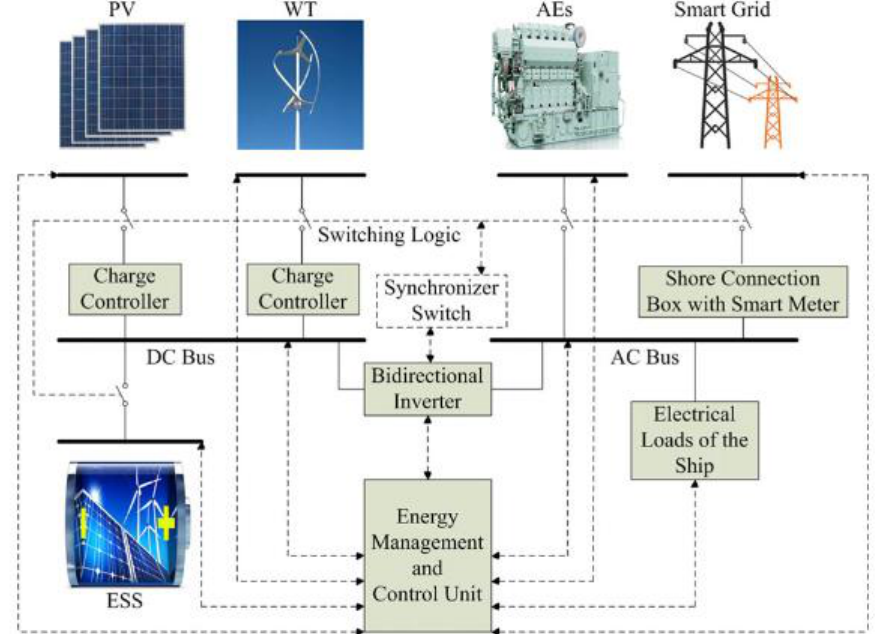
Figure 23. Control and power switching topology for the ship and smart grid system. Reprinted with permission from ref. [103]. Copyright © 2018 John Wiley & Sons, Ltd.